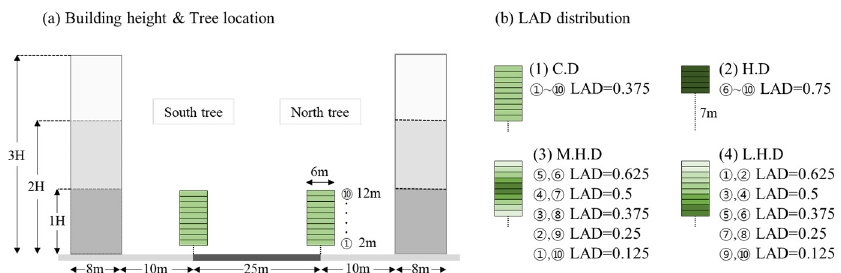
Figure 3. Domain for simulation. ( a ) Geometric settings ( b ) Tree settings. The darker the color, the higher the leaf area density.